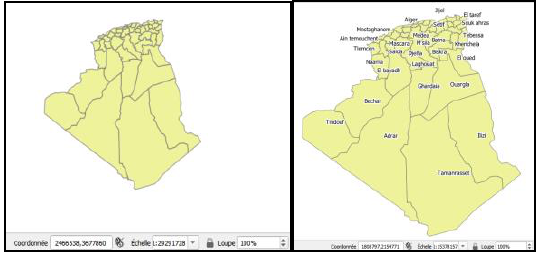
Figure 5. Example of multi-scale